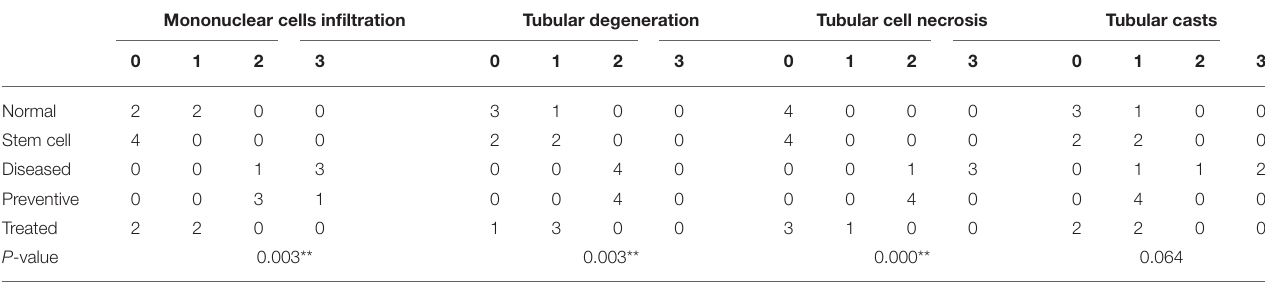
TABLE 2 | Kidney histopathological changes (mononuclear cell infiltration, tubular degeneration, tubular cell necrosis, and tubular casts) in the study groups. Mononuclear cells infiltration Tubular degeneration Tubular cell necrosis Tubular